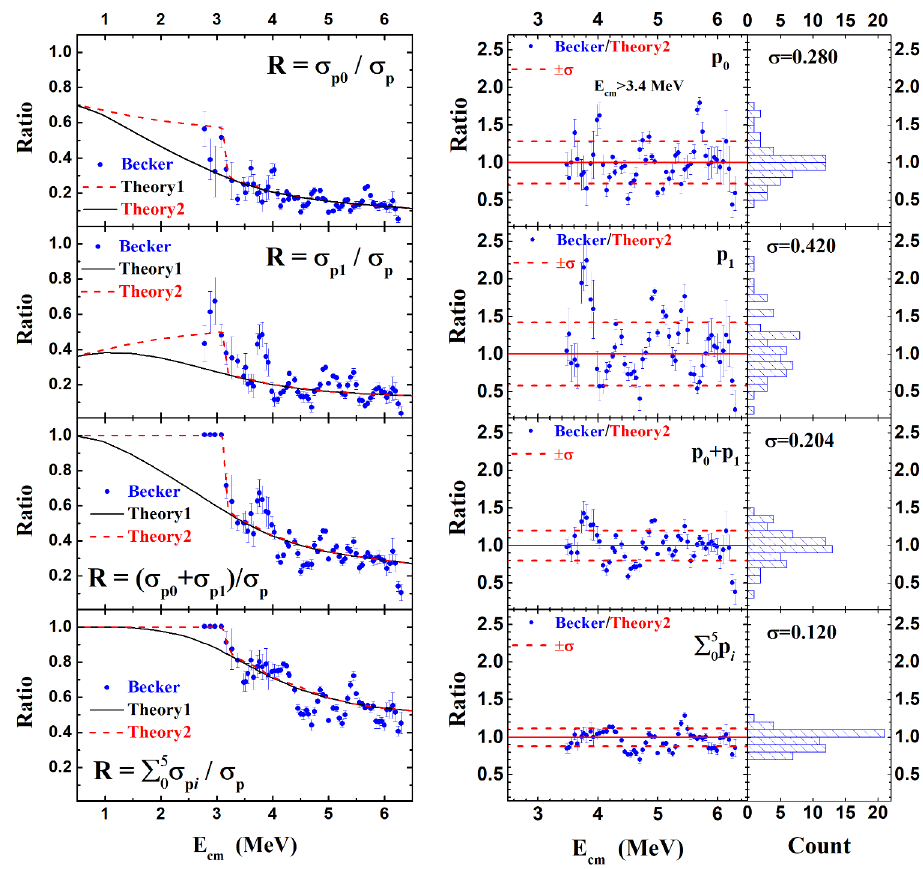
Figure 3. The comparison of the branching ratios calculated with experimental data [9] for the p- channel. (left) The calculated σ p experimental data of Becker et al. [9]. Theory1 is the present calculation by Talys, Theory2 takes the condition of the cut-o ff exist in the experiment of Becker et al. [9] into consideration. (right) The values of Becker / Theory2 for the ratios shown in (left) are calculated and displayed. The statistics are also achieved with average value (Mean = 1) and standard deviation ( σ ). The standard deviation ( σ ) according to Mean = 1.0 is given together with the Becker /